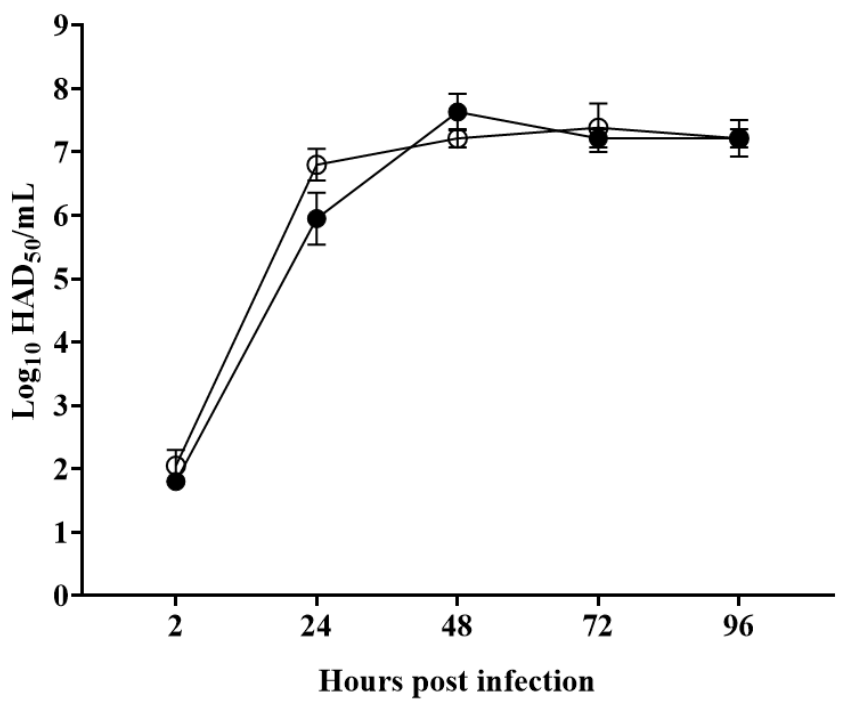
Figure 4. In vitro growth kinetics in primary swine macrophage cell cultures for ASFV-G- ∆ MGF360-1L. Macrophages cultures were infected (MOI = 0.01) with either ASFV-G- ∆ MGF360-1L (filled circles) or parental ASFV-G (empty circles) viruses. Samples were taken from three independent experiments at the indicated time points and titrated. Data represent means and standard deviations. Sensitivity using this methodology for detecting virus: ≥ log 10 1.8 HAD 50 / mL. (Median Hemeadsorbing infectious dose / milliliter) No significant di ff erences in viral yields between viruses are observed at any time point tested determined using the Holm–Sidak method ( α = 0.05), without assuming a consistent standard deviation. All calculations were conducted using the software Graphpad Prism version 8.